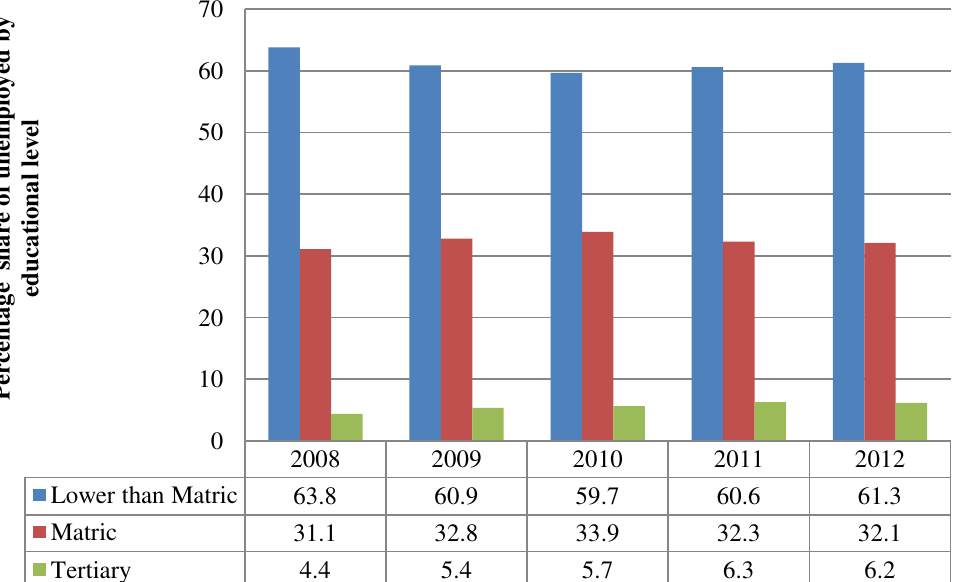
Fig. 3. Share of the unemployed by educational level, South Africa, 2008-2012 Source: Stats SA, Q4